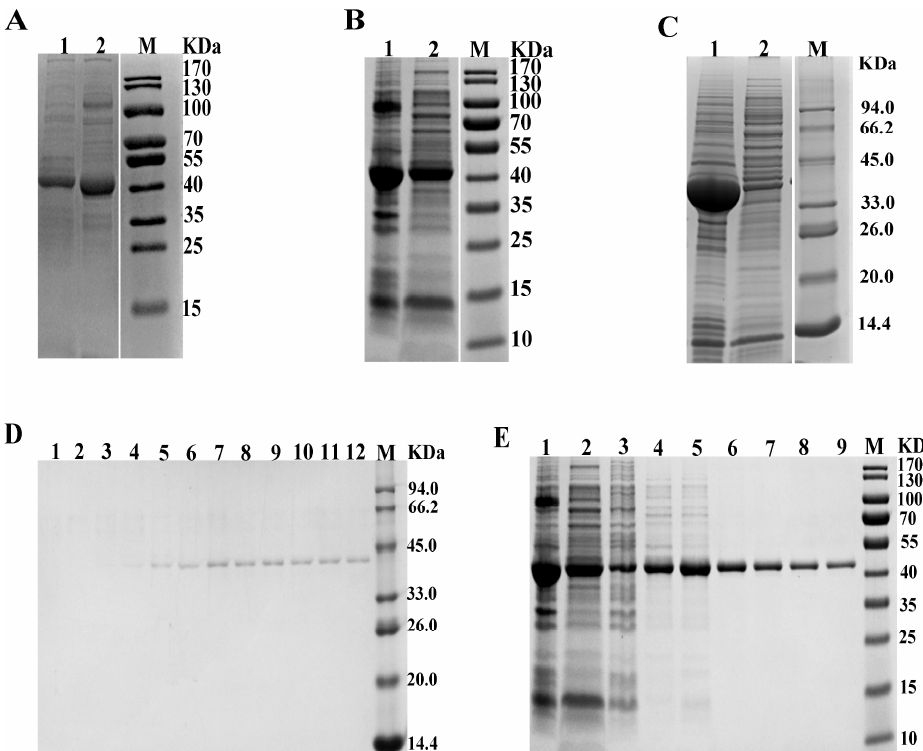
Figure 2. Isolation and puri fi cation of the recombinant FtsZ protein at di ff erent ultrasonic powers and imidazole concentrations. ( A ) Isolation of FtsZ protein at ultrasonic power 227.5 W. Lane 1: sediment after ultrasound; lane 2: supernatant after ultrasound; M: marker. ( B ) Isolation of FtsZ protein at 162.5 W. Lane 1: sediment after ultrasound; lane 2: supernatant after ultrasound; M: marker. ( C ) Isolation of FtsZ protein at 97.5 W. Lane 1: sediment after ultrasound; lane 2: superna- tant after ultrasound; M: marker. ( D ) E ff ect of imidazole concentrations on elution of FtsZ. Lane 1: